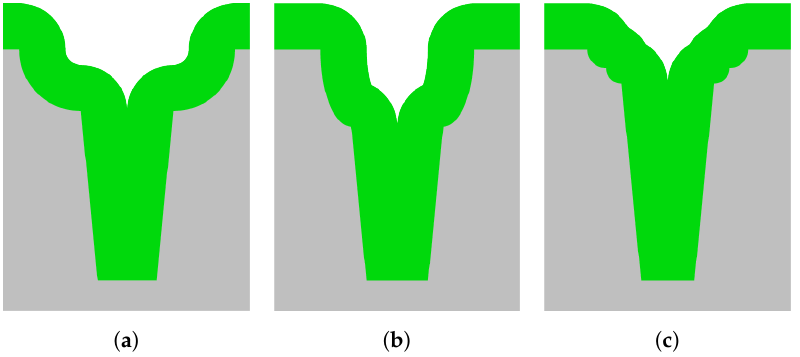
Figure 8. Schematic representations of refilled positively-tapered trenches with different